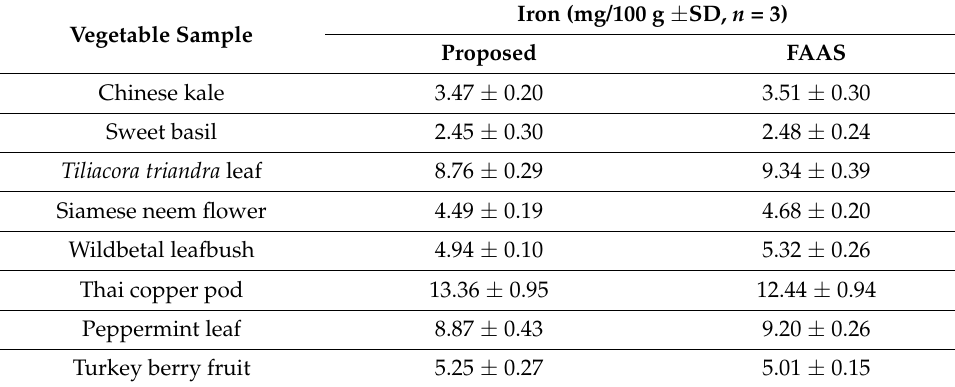
Table 2. Iron concentration in vegetables analyzed by the developed method and